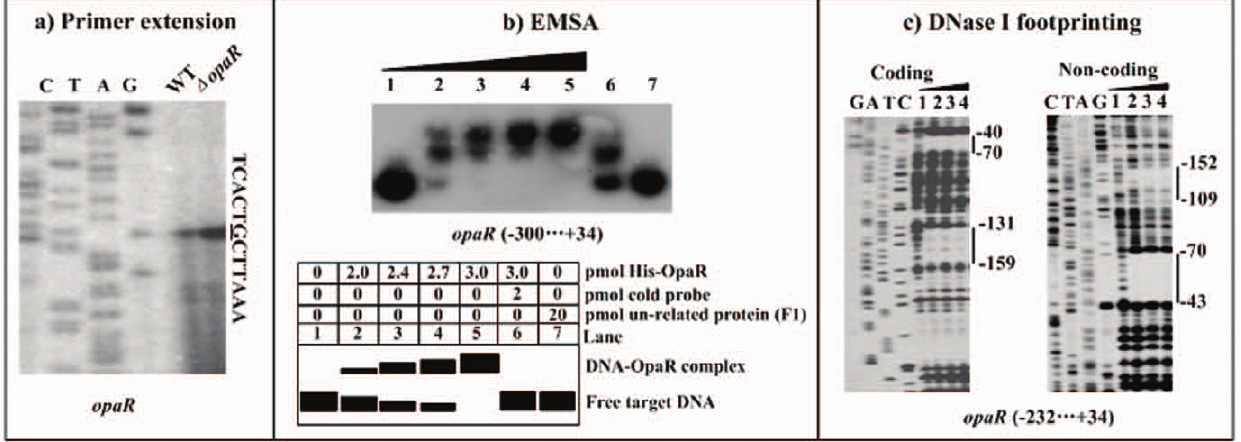
Figure 5. Repression of its own gene by OpaR. a ) Primer extension. An oligonucleotide primer was designed to be complementary to the RNA transcript of opaR . The primer extension products were analyzed with 8 M urea-6% acrylamide sequencing gel. Lanes C, T, A, and G represent the Sanger sequencing reactions. The transcription start site of opaR was underlined in the DNA sequence. b ) EMSA. The radioactively labeled DNA fragment from the 300th bp upstream to the 34th bp downstream of opaR was incubated with increasing amounts of purified His-OpaR protein, and then subjected to 4% (w/v) polyacrylamide gel electrophoresis. The band of free DNA disappeared with increasing amounts of His-OpaR protein, and a retarded DNA band with decreased mobility turned up, which presumably represented the DNA-OpaR complex. Shown on the lower side of the figure was the schematic representation of the EMSA design. c ) DNase I footprinting. Labeled coding or non-coding DNA probes were incubated with increasing amounts of purified His-OpaR (Lanes 1, 2, 3, and 4 containing 0, 6, 9, and 12 pmol, respectively), and subjected to DNase I footprinting assay. Lanes G, A, T, and C represented the Sanger sequencing reactions. The footprint regions were indicated with vertical bars. The negative or positive numbers indicated the nucleotide positions upstream or downstream of opaR , respectively.